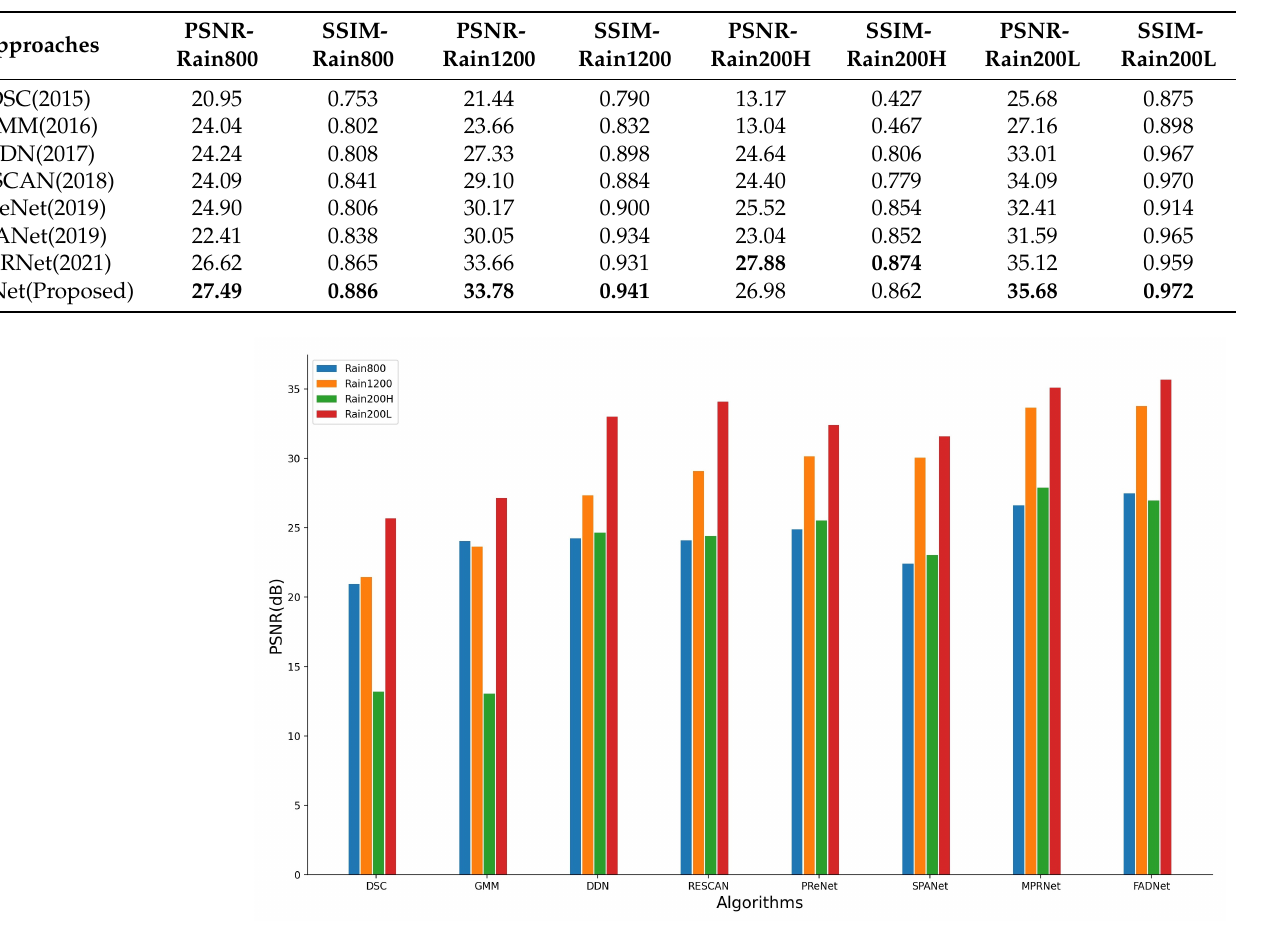
Figure 6. PSNR value of different